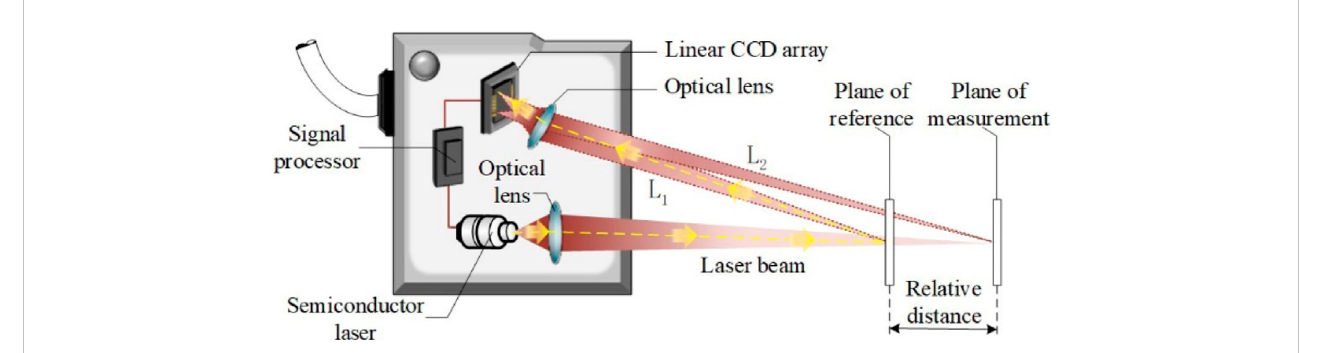
FIGURE 1 Laser triangulation test principle diagram.